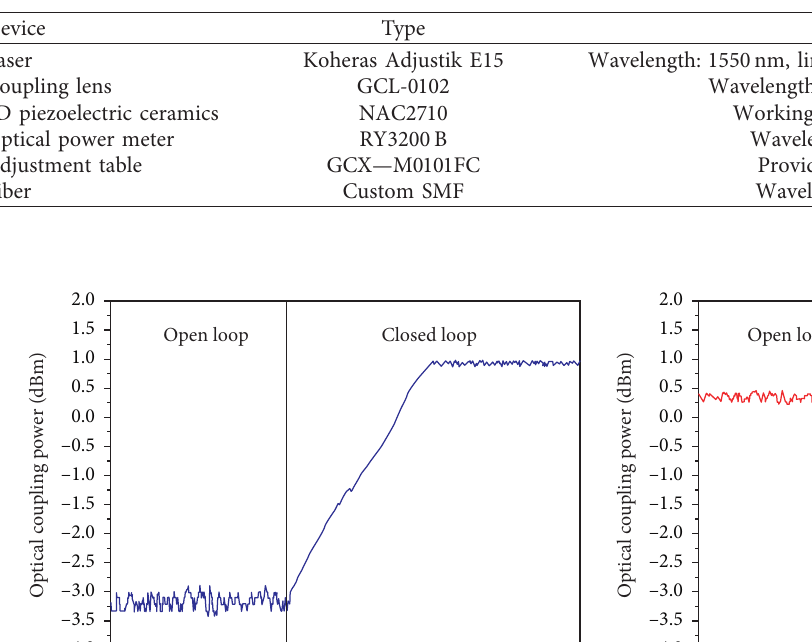
Table 1: Optical fiber coupling automatic alignment experimental device.